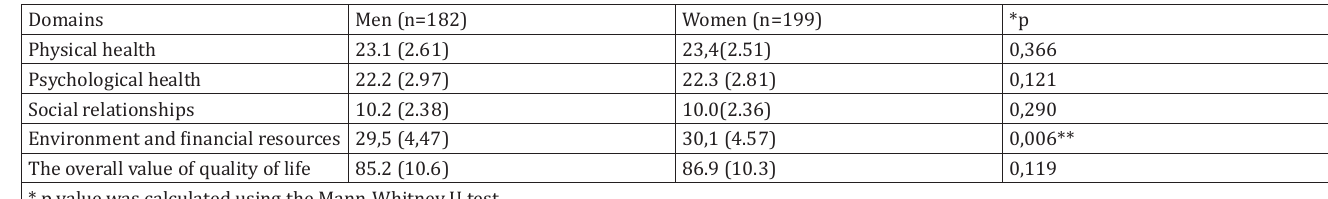
Comparison of qualitative data by domains of the questionnaire depending on